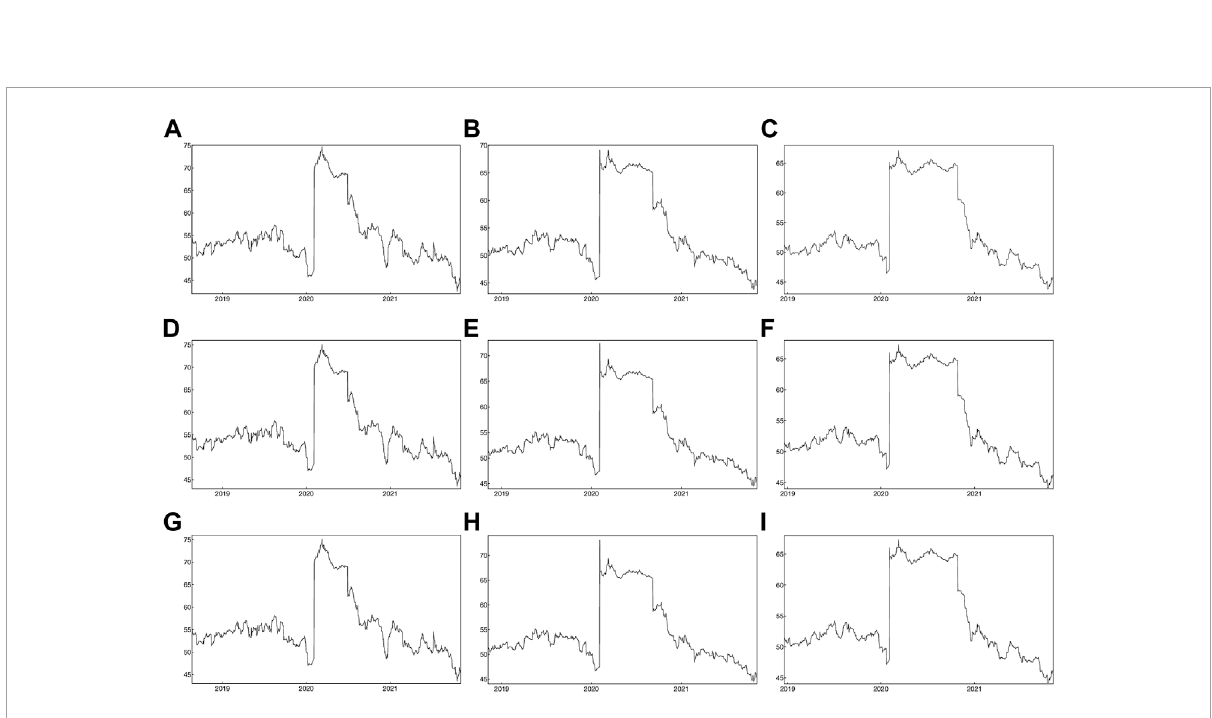
FIGURE 6 Robustness checks: (A) 2-days forecast horizon and 100-days rolling windows; (B) 2-days forecast horizon and 150-days rolling windows; (C) 2-days forecast horizon and 180-days rolling windows; (D) 5-days forecast horizon and 100-days rolling windows; (E) 5-days forecast horizon and 150-days rolling windows; (F) 5-days forecast horizon and 180-days rolling windows; (G) 8-days forecast horizon and 100-days rolling windows; (H) 8-days forecast horizon and 150-days rolling windows; (I) 8-days forecast horizon and 180-days rolling